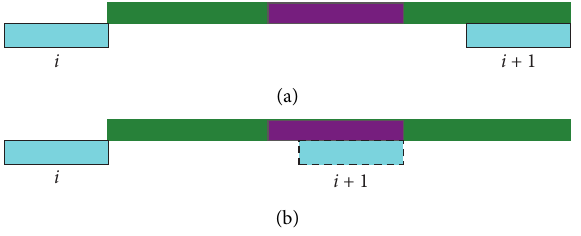
Figure 5: Strategy for tracking-oriented